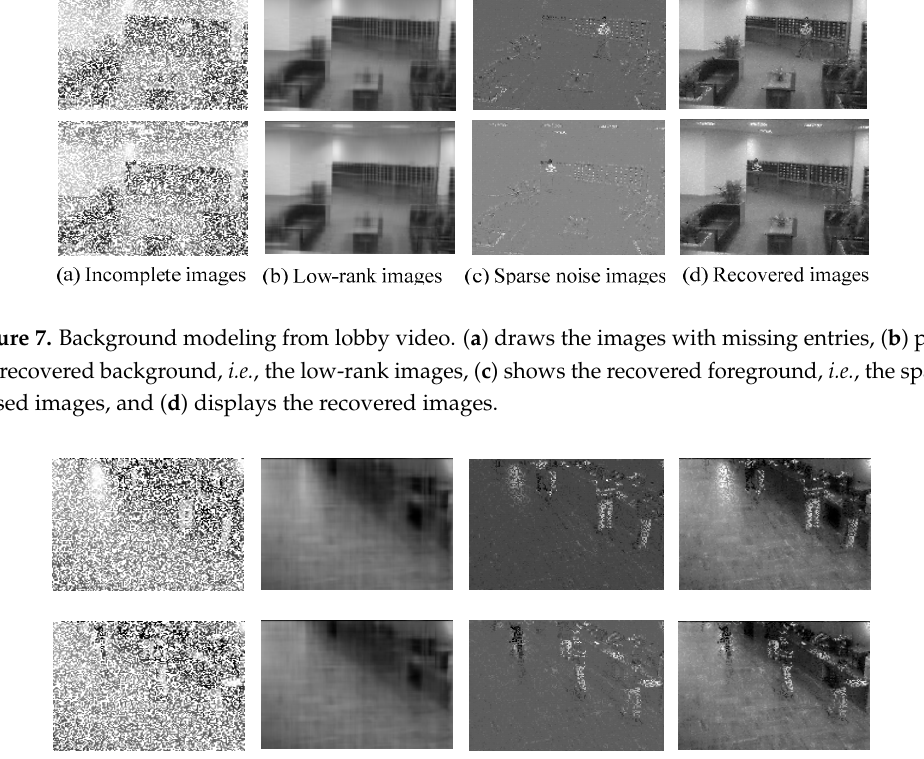
Figure 8. Background modeling from bootstrap video. ( a ) draws the images with missing entries, ( b ) plots the recovered background, i.e. , the low-rank images, ( c ) shows the recovered foreground, i.e. , the sparse noised images, and ( d ) diplays the recovered images.